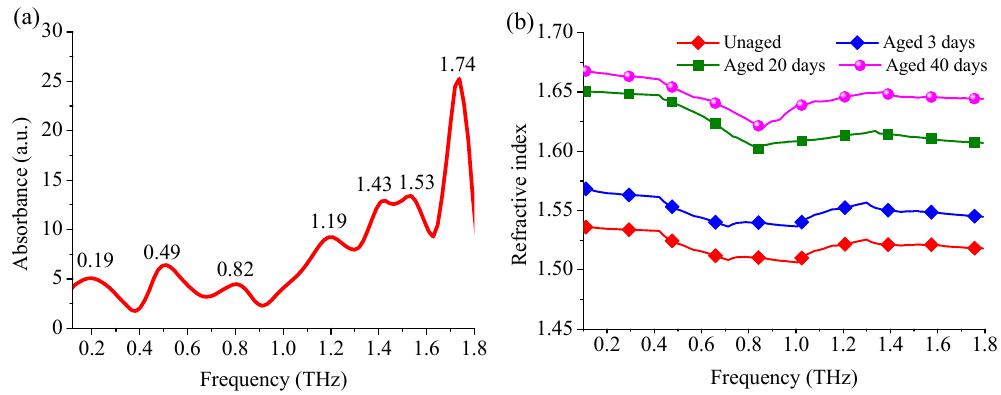
Figure 3. Optical parameters of transformer insulation paper. ( a ) Absorption coefficients of unaged paper; ( b ) Refractive indices of unaged paper and paper aged for 3, 20, and 40 days at 403 K.